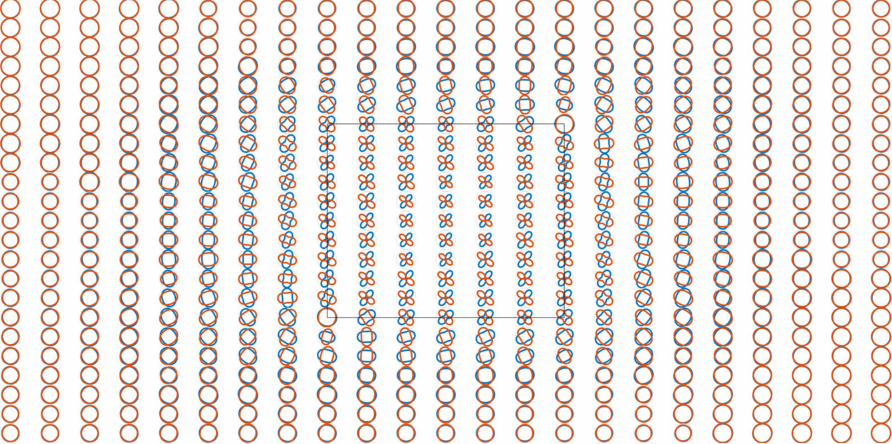
Figure 12. Polar plots of modified COMMEMI 3D-1A model for a frequency of 0.57 Hz. Principal conductivity rotation around the z -axis by 30 ◦ .